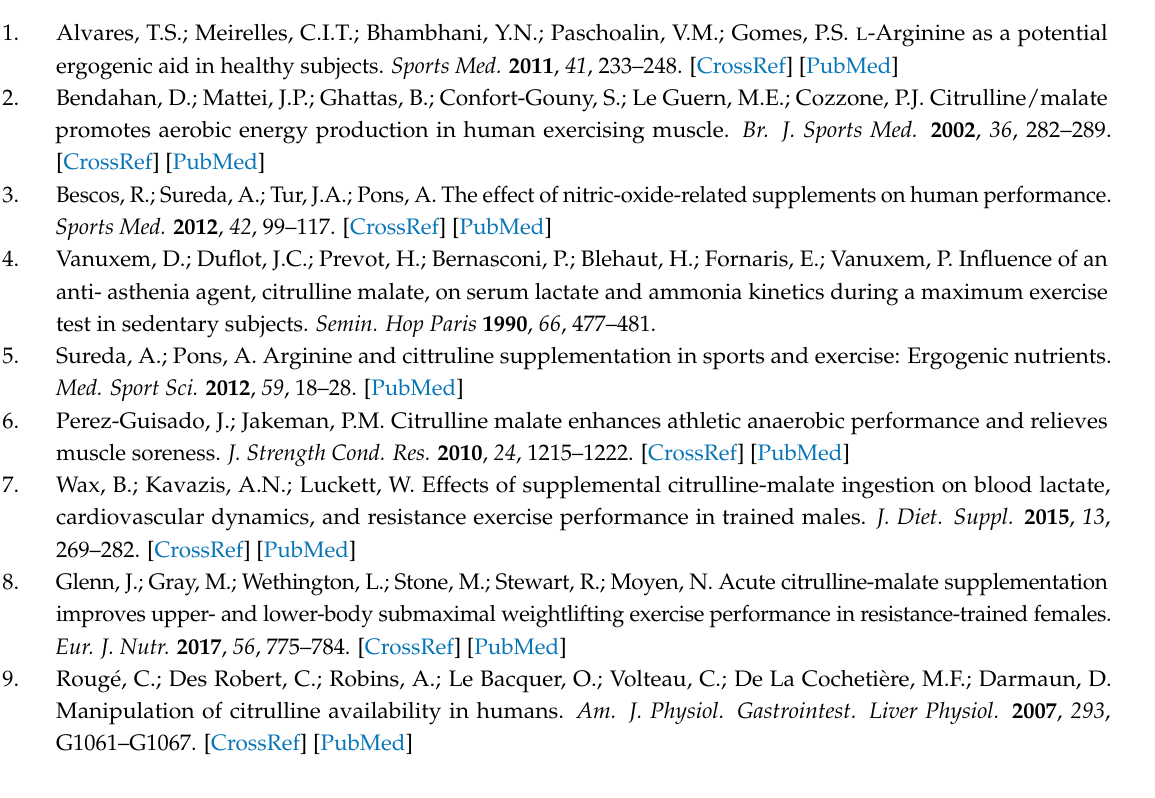
Figure S1: Effect size (95% CI) for muscle recovery variables (Number of maximum repetitions in the leg press (A) and hack squat (B), levels of CK (C), lactate (D), and values of RMS (E) and soreness (F)) between CM and PL at 24, 48, and 72 h